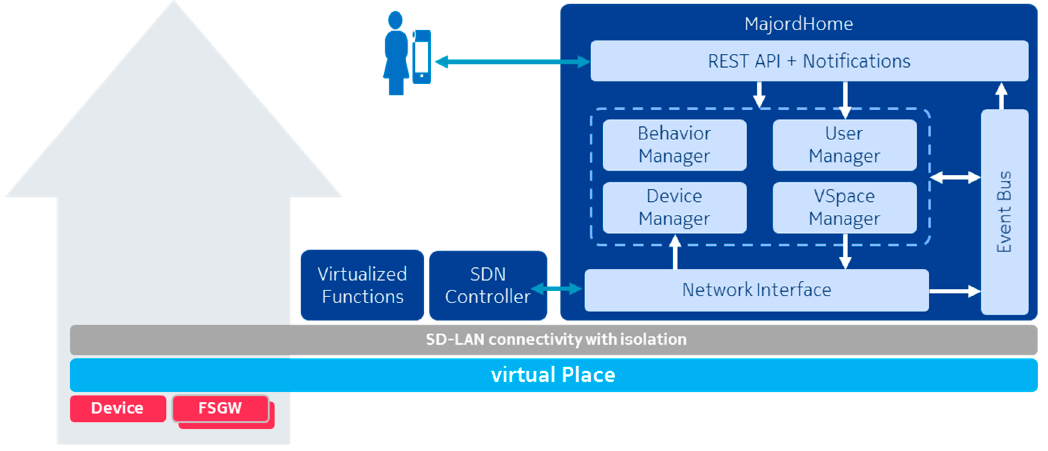
Figure 11. Architecture of the MajordHome showing interfaces with other components of the Future Spaces solution.